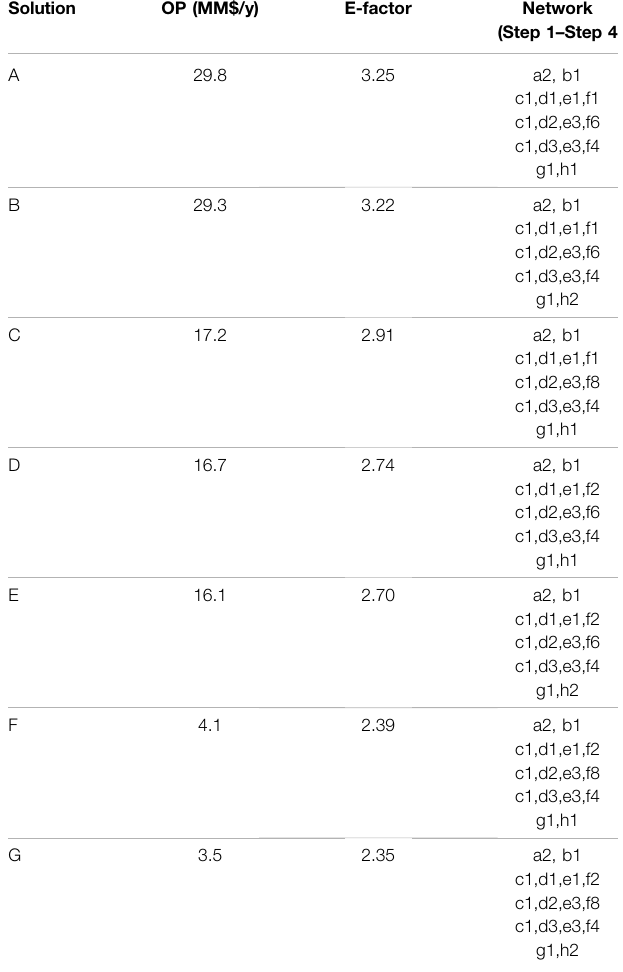
TABLE 2 | Pareto of solutions as presented in Figure 6 : OP, E-factor, and production network.